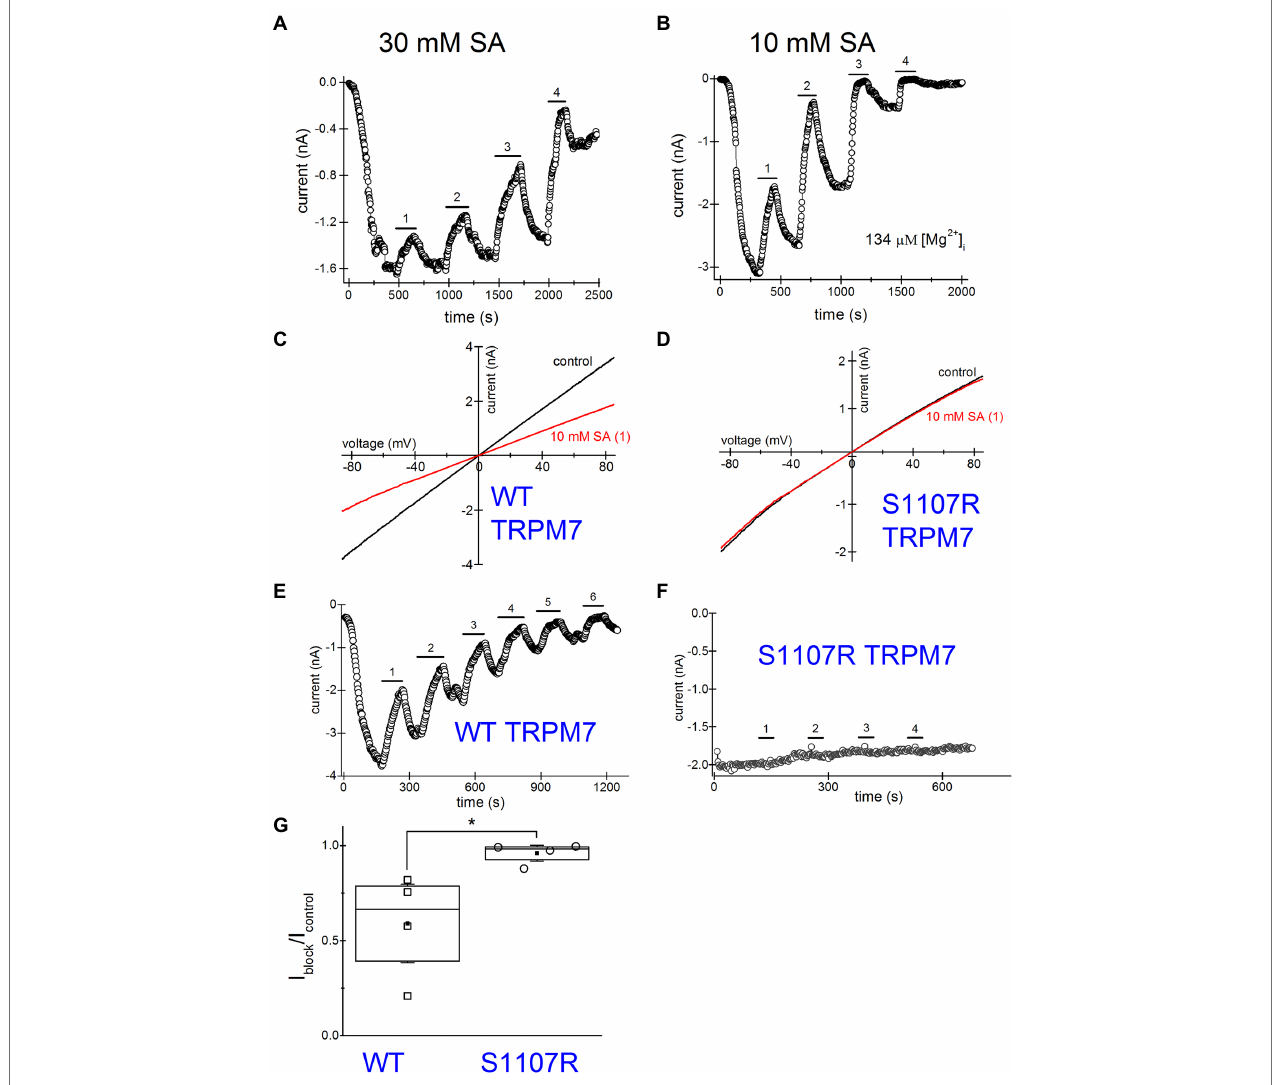
FIGURE 7 | Increased inhibition of TRPM7 current revealed by multiple applications of salicylate. Salicylate effect on WT and S1107R TRPM7. (A) Effect of repeated application of 30 mM salicylate on the native TRPM7 current in Jurkat T cells. The internal solution contained no added Mg 2+ . (B) Repeated application of 10 mM salicylate in a Jurkat T cell. The internal solution contained 134 μ M free [Mg 2+ ]. (C,D) I–V relations obtained in the absence and presence of 10 mM salicylate (first application) in HEK293 cells expressing WT (C) and S1107R (D) mTRPM7. (E,F) The time course of repeated salicylate applications in the same experiments as (C,D) , respectively. (G) Fraction of current block by 10 mM salicylate of WT and S1107R mutant mTRPM7 channels during second application of the drug (see E,F ). Current amplitude was measured at the 30 th ramp during drug application (I block ) and divided by the amplitude immediately before drug application (I control ). The current amplitudes were measured at − 85 mV. The internal and external recording solutions were Cs + based. * p < 0.05, Student’s pairwise t